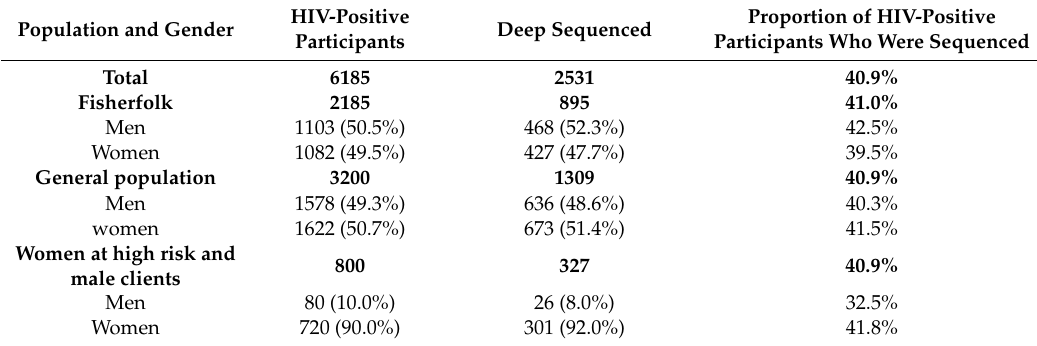
Figure 1. Map showing the sampling sites. Sites 1 to 10 show the fisherfolk (FF) communities and sites A to C show areas where women at high risk of HIV-1 infection (WHR) and some of their clients were enrolled. Locations 1 to 6 show areas in the general population (GP) where study participants were Table 1) shown on the map in south central Uganda had their samples deep sequenced and subjected to phylogenetic analyses. Table 1. Study population, and proportion of sampled and sequenced